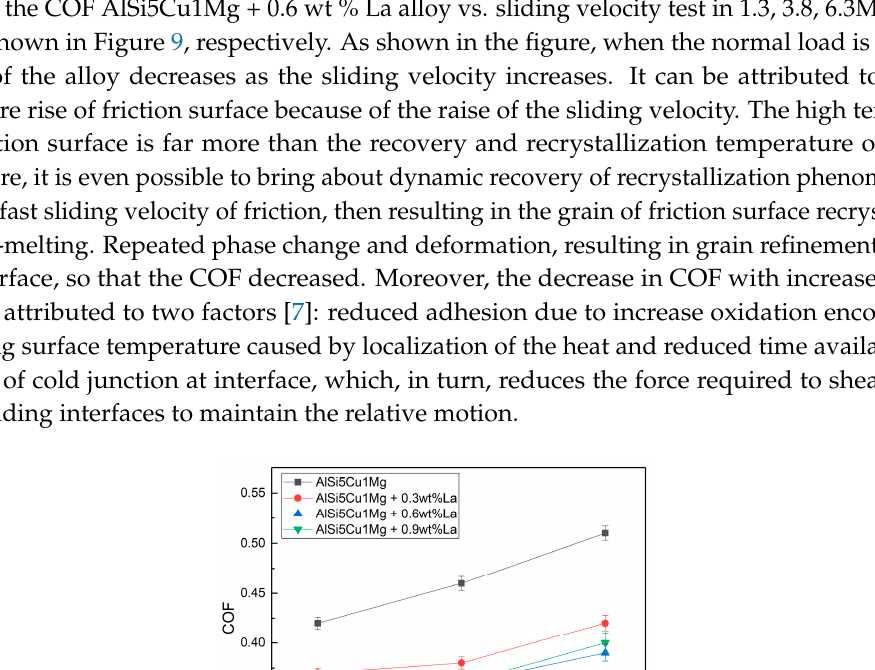
Figure 9. Coefficient of friction (COF) of AlSi5Cu1Mg + 0.6 wt % La alloy: ( a ) 1.3 MPa normal load; ( b ) 3.8 MPa normal load; ( c ) 6.3 MPa normal load. 3.4. Worn Surfaces As it can be seen in Figure 10, the scanning electron microscope (SEM) micrographs of worn out surfaces for AlSi5Cu1Mg + 0 wt %, 0.3 wt %, 0.6 wt %, 0.9 wt % La alloys subjected to 0.19 m/s sliding velocity and 3.8 MPa normal load. A lot of valuable information on the mechanism of wear can be provided by studying the worn surfaces [36]. The worn surface of matrix alloy tested at the sliding velocity of 0.19 m/s and the normal load of 3.8 MPa exhibiting parallel grooves and scratches together with rows of furrows and smearing in plastically deformed regions are shown in Figure 10a. These parallel grooves and scratches on the worn surface indicate the occurrence of abrasive wear, which resulted from abrasive contact between the hardened steel disc and aluminium pin. Plastic deformation of surface with rows of furrows is an indicator of adhesive wear. La content increased to 0.3 wt %. As shown in Figure 10b, the shallow craters disappeared, which means that the adhesion wear was reduced. When the content of La increased to 0.6 wt %, the craters on the worn surface almost disappeared, as shown in Figure 10c. It indicates that the wear mechanism of AlSi5Cu1Mg + 0.6 wt % La alloy tested at the sliding velocity of 0.19 m/s and the normal load of 3.8 MPa is mainly abrasive wear because of the maximum hardness, as shown in Figure 4. Nevertheless, by increasing the content of La to 0.9 wt %, as shown in Figure 10d, the adhesive wear appeared again, and the size of the craters is greater. This indicates that the wear mechanism of AlSi5Cu1Mg + 0.9 wt % La alloy tend to be adhesive, due to the deterioration of modification effect. When surfaces come into contact with each other, the films that naturally occur on surfaces often separate the atoms or molecules so there is no tendency for adhesion. However, if the force pushing contacting surfaces becomes sufficient locally at spots in the real area of contact, films can break down and the atoms or molecules of the mating surfaces can make atomic contact and atomic bonding can occur. Then, the surface of the material with less hardness does fall off and stick to the surface of the material with higher hardness. It is called a “metal transfer” [37] phenomenon. Furthermore, the hardness of alloy increases because of the modification by the rare earth element La, the hardness ratio of the